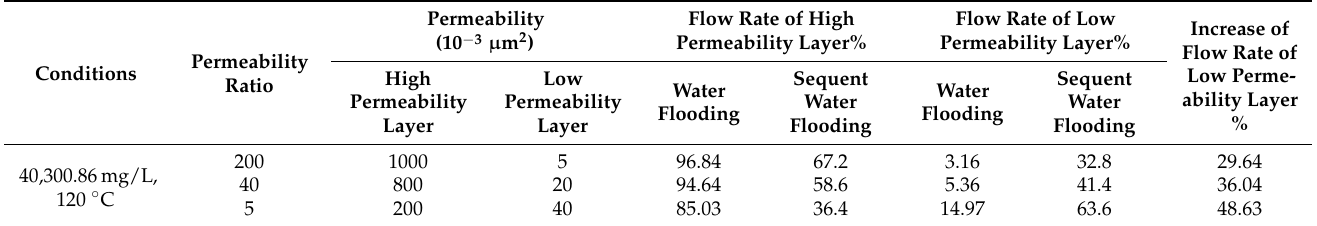
Table 3. Diversion rates of cores recorded under conditions of varying permeability levels.